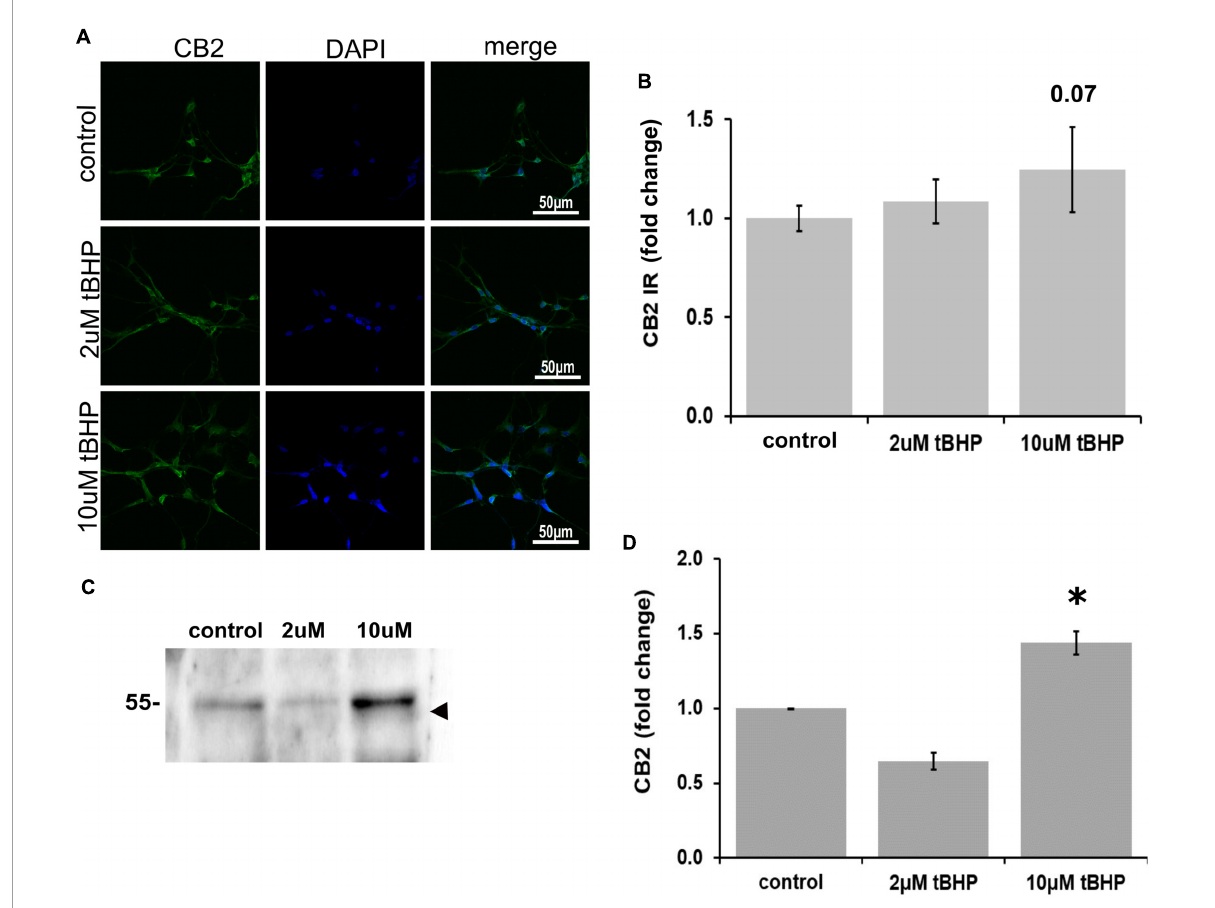
FIGURE3 Expression of cannabinoid receptor type 2 (CB2) in ReN cells under conditions of oxidative stress. (A) Images show that tert-butylhydroperoxide (tBHP) has no apparent effect on CB2 IR (green). Blue are DAPI-labeled nuclei. Images are 400 × magnification. (B) Quantitative analysis of images in panel (A) reveals that tBHP has no significant effect on CB2 IR, although a trend toward an increase exists (0.10 < p < 0.05). (C,D) Western blot analysis reveals that the expression of a 48 kDa band (expected molecular weight of glycosylated CB2 is 46 kDa) corresponding to CB2 is downregulated by 40% by exposure to 2 µ M tBHP and upregulated 45% by exposure to 10 µ M tBHP. * p ≤